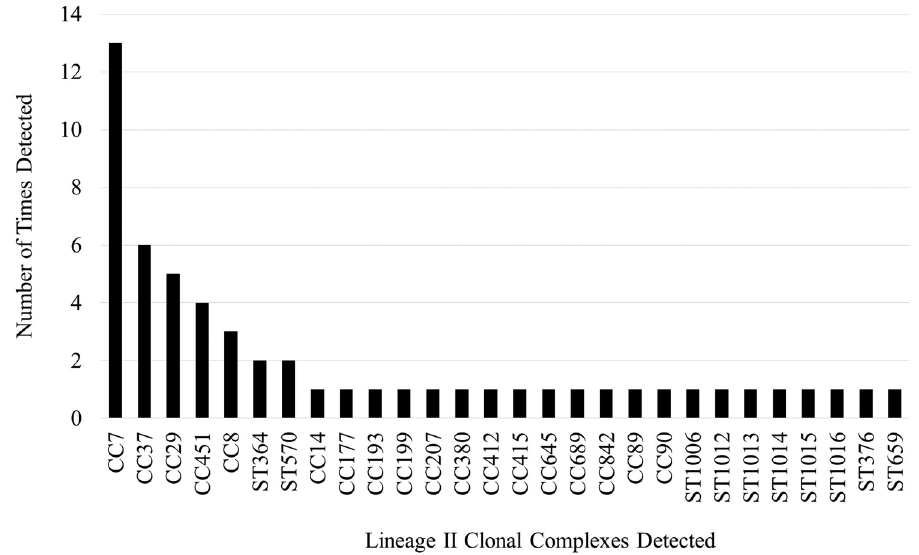
Fig 3. Frequency of detection for all lineage II clonal